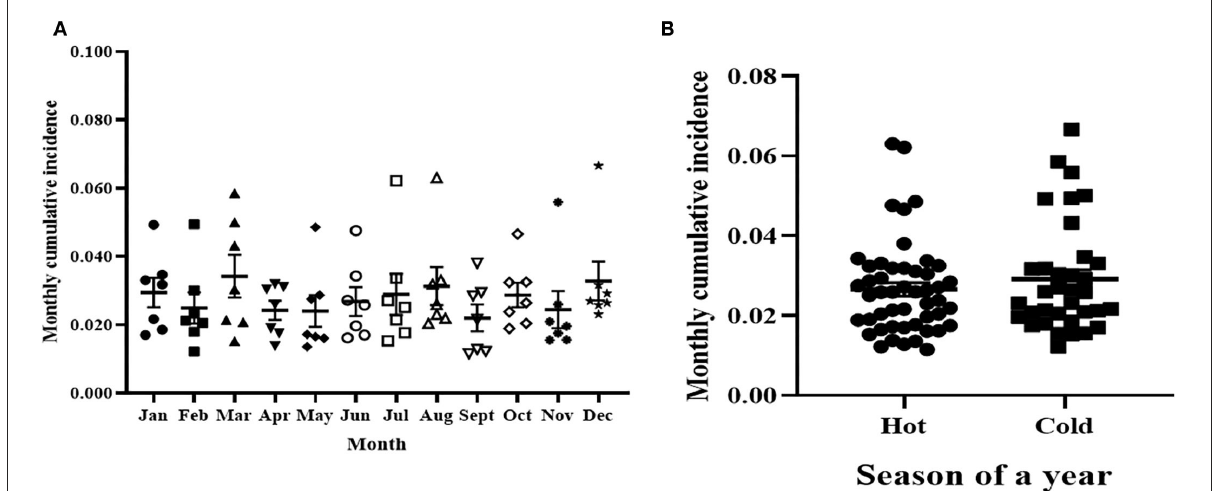
FIGURE4 The cumulative incidence of clinical mastitis during the months (A) and seasons (B) of years. (A) The average cumulative incidence of clinical mastitis during the months of the 7 years. The difference in monthly cumulative incidence of clinical mastitis was not statistical significantly. (B) The average cumulative incidence of clinical mastitis during the hot and cold seasons of the year. Furthermore, there was no difference (0.027; 95% CI = 0.023–0.030) in average monthly cumulative incidence of clinical mastitis between the hot and relatively cold (0.029; 95% CI = 0.024–0.034) seasons.